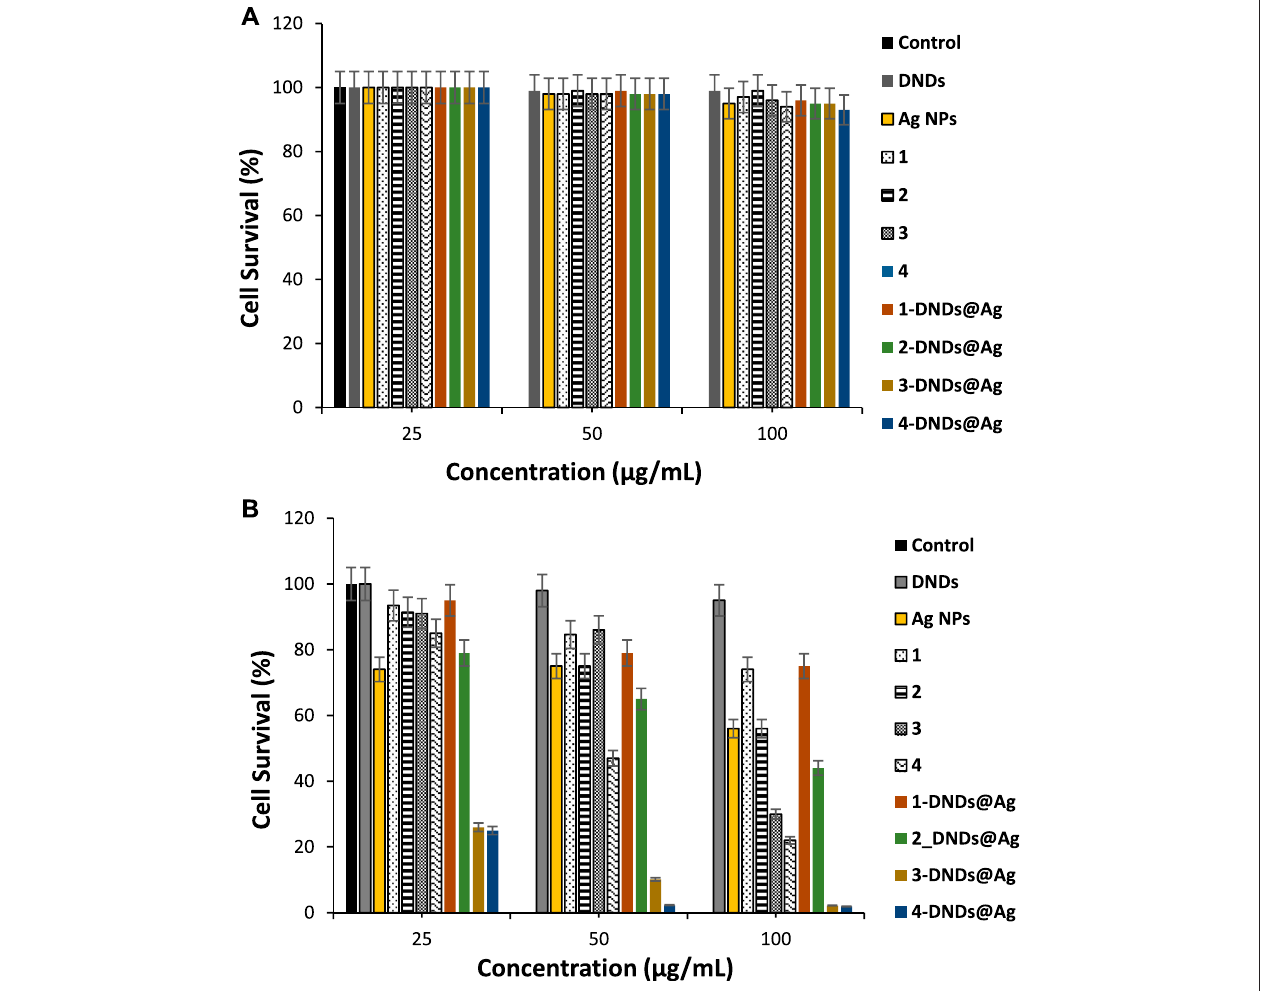
FIGURE11|(A) Darktoxicitystudiesand, (B) Photoinhibitionstudiesofthesynthesizedcompoundson S.aureus bio fi lmscells(30 minirradiationat415 nm).Data represent the mean ± SD (standard deviation).